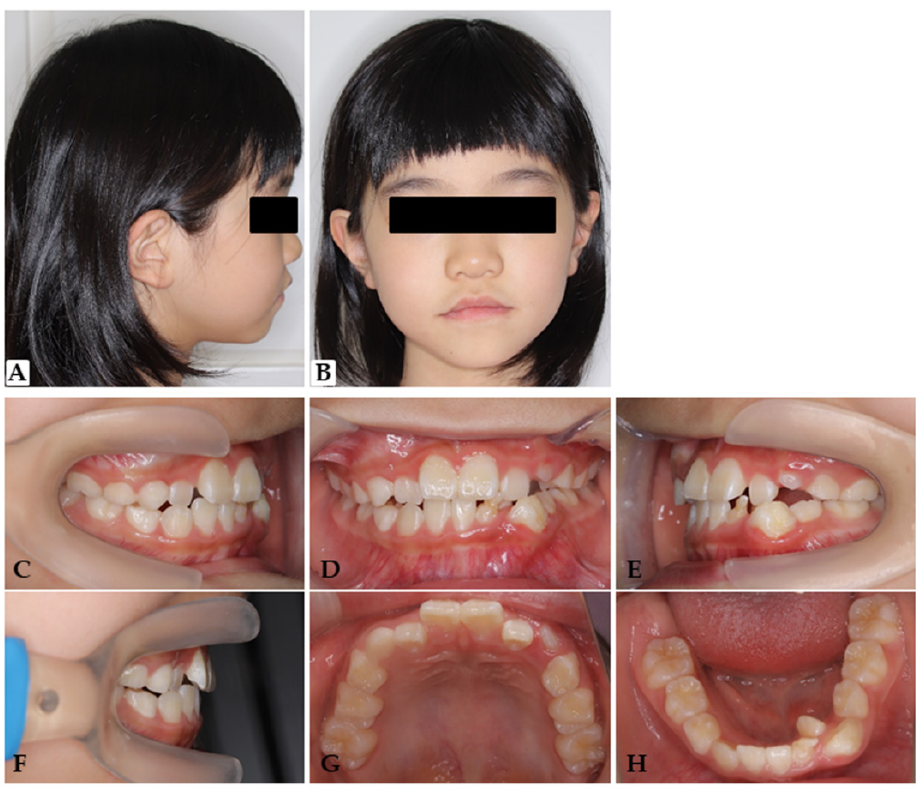
Figure 3. Treatment progress; five months after the start of maxillary protraction, the overjet was corrected. ( A ) Lateral view; ( B ) frontal view; ( C ) right molar relationship; ( D ) centric occlusion; ( E ) left molar relationship; ( F ) overjet; ( G ) mirror view (maxillary); ( H ) mirror view (mandibular).